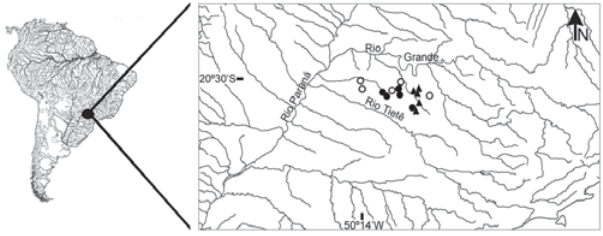
Fig. 2. Location of the preserved (PRE, open circles), intermediate (INT, dark circles), and degraded (DEG, triangles) sites in the northwestern portion of the state of São Paulo, Brazil.